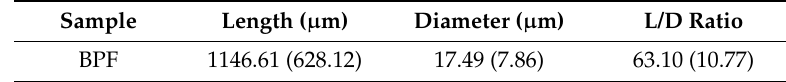
Table 2. Initial length of bamboo fibers.